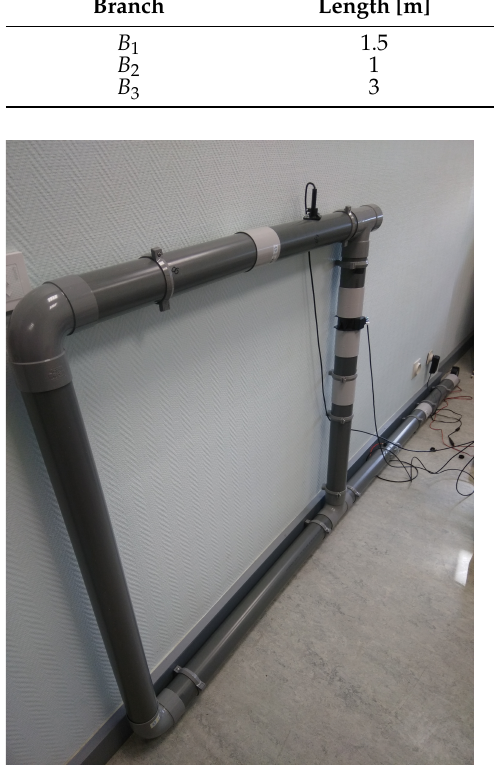
Figure 6. Experimental set-up of a ventilation network: The benchmark is built to emulate conditions in a typical small mine, a scale 1:500 has been used in order to configure the crosssection of the